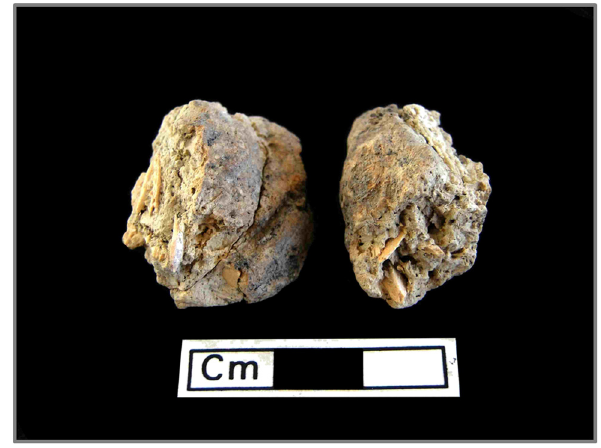
Figure 12: Animal coprolite ( from midden deposit, unit 17670, Space 420, TP Area, Level TP.M, Çatalhöyük East ) . ( Photo by K. Paw ł owska )